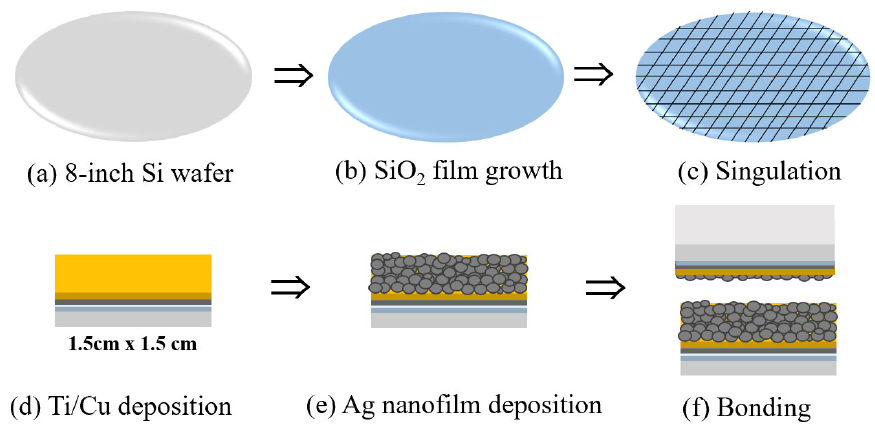
Figure 1. Schematic diagram of the process flow.